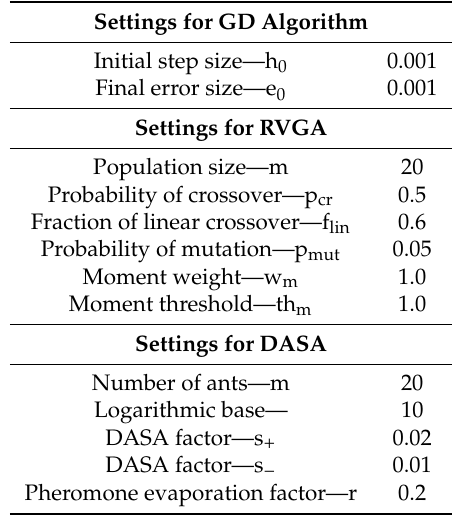
Table 5. Parameter settings for the RVGA and DASA optimisation